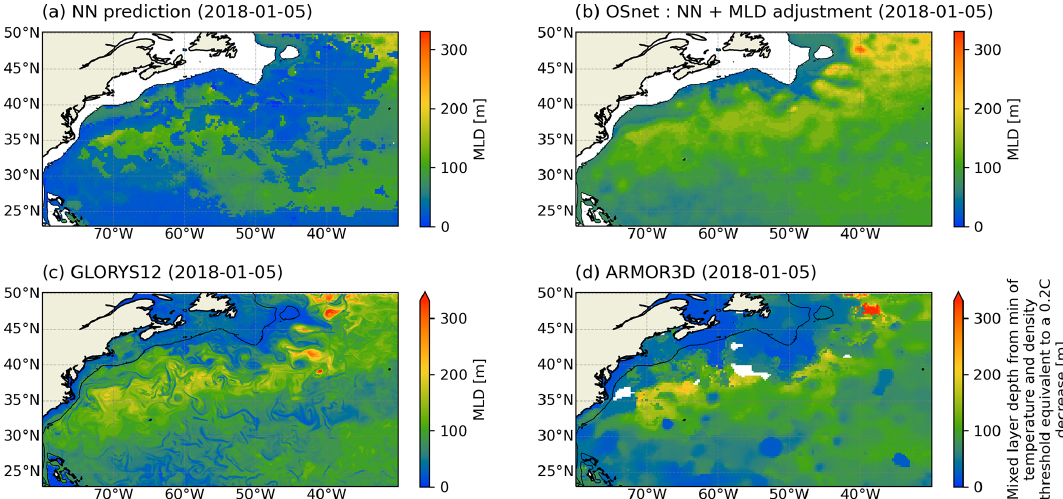
Figure 8. MLD maps for 5 January 2018. Panel (a) shows the result of the NN alone (step 1 from the schematic Fig. 2) and panel (b) is the final OSnet product. Panels (c) and (d) are the MLDs of the TS profiles of Glorys12 and Armor3D. Armor3D is a weekly product, so the profiles here are for the first week of January 2018. All the MLDs are computed with the density criterion of 0.03, except for Armor3D, for which a different criterion is provided to bypass their density inversion issues. The shelf break is traced in black with the bathymetry contour of 1000m. The maximum of the color bar is set by the maximum of